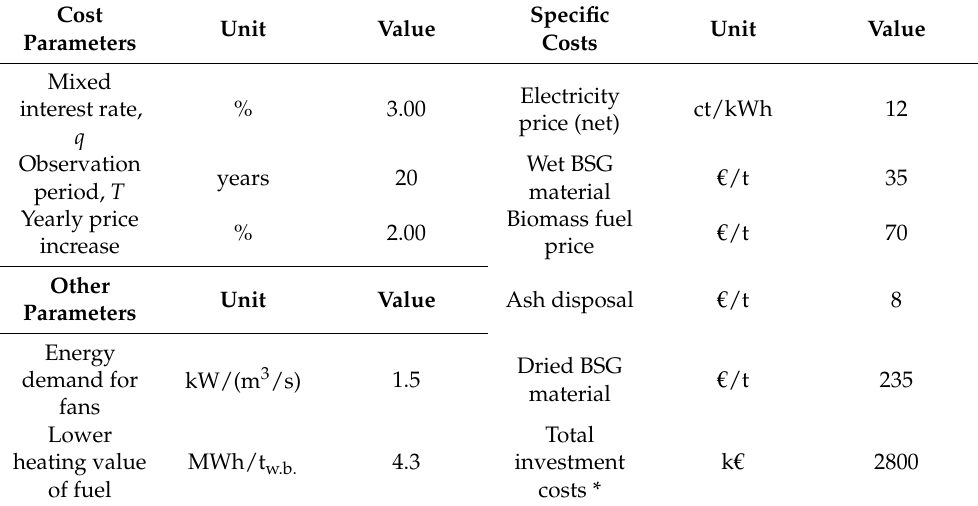
Table 5. Parameters used in the cost